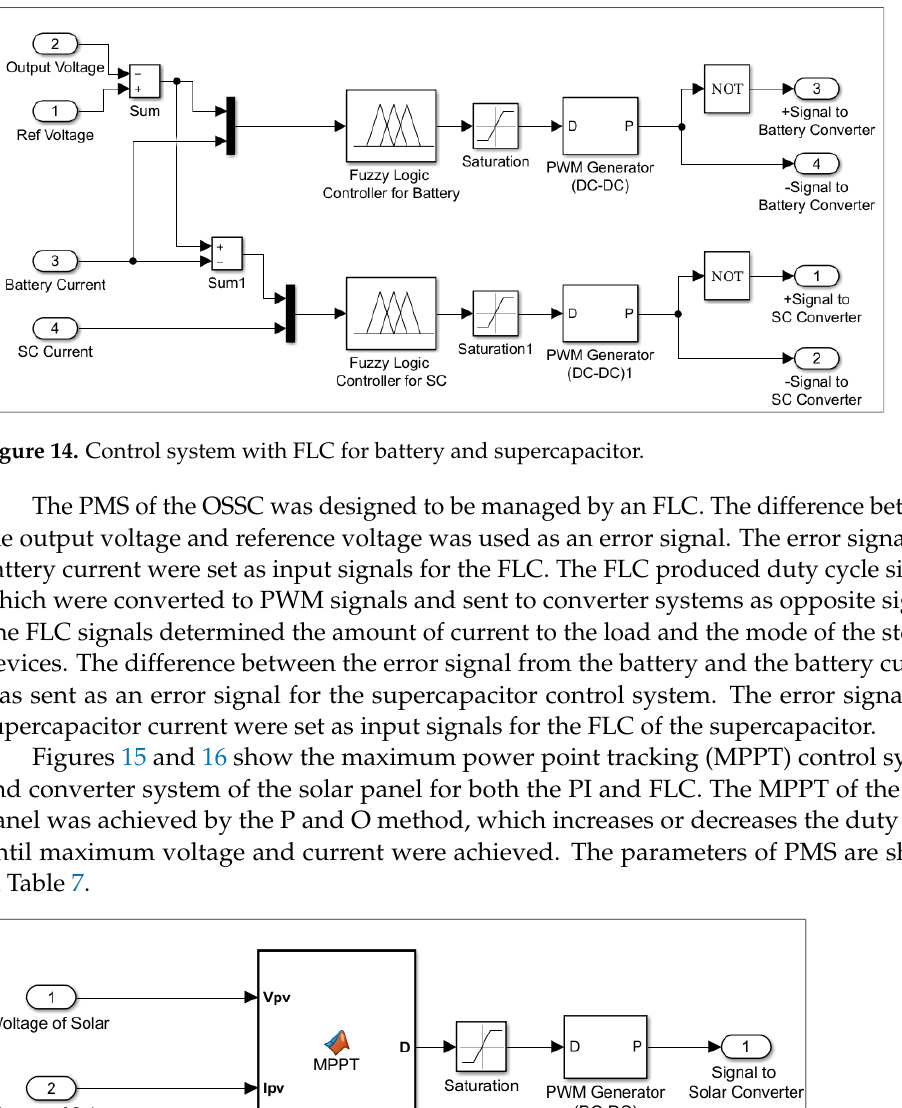
Figure 13. Voltage and current profiles for ( a ) supercapacitor and ( b ) auxiliary battery profile.